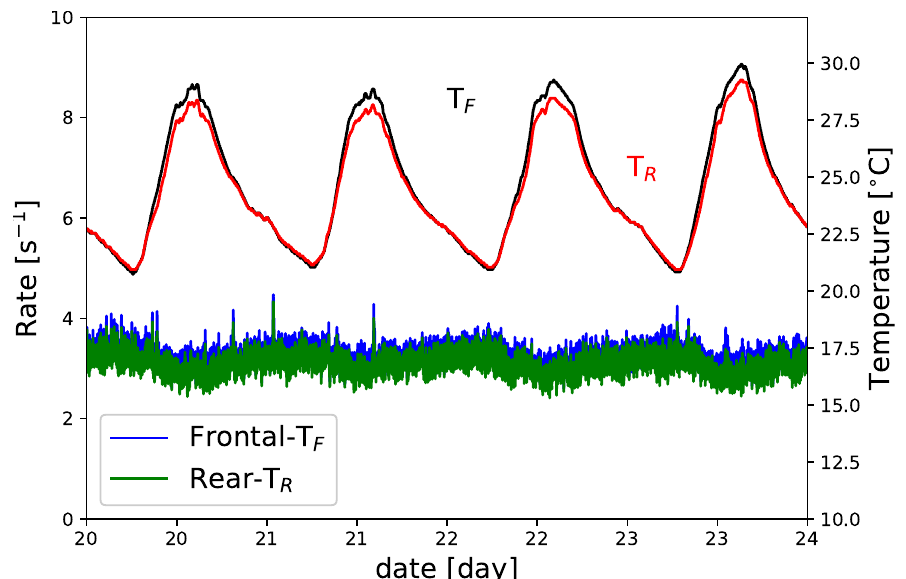
Figure 15. In-coincidence hodoscope rate modulation depending on the environmental temperature of the MuTe recorded from 20 December 2019 to 25 December 2019. The green line displays the rear panel rate under temperature T R and the blue line the frontal panel rate under temperature T F